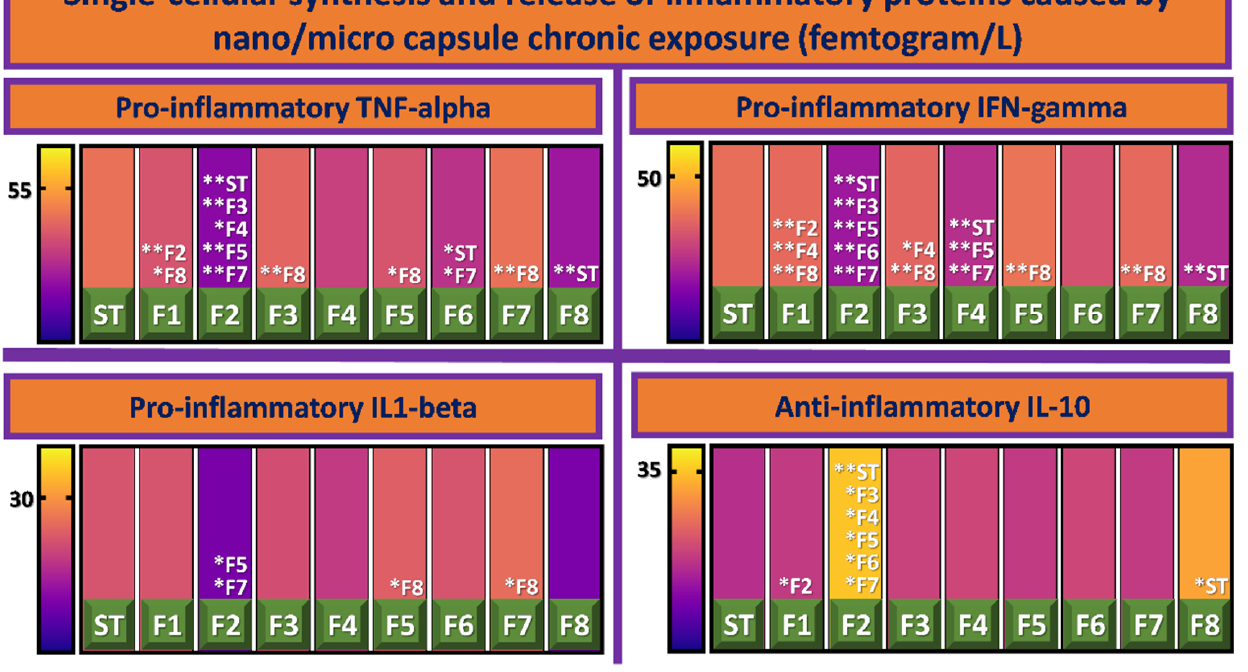
Figure 3. Single-cellular synthesis and release of inflammatory proteins caused by nano/micro capsule chronic exposure (femtogram/L). Inflammatory proteins include TNF-alpha ( top , left ), IFN- gamma ( top , right ), IL1-beta ( bottom , left ), and IL-10 ( bottom , right ). Data are mean ± standard error of the mean, n = 3. Singular asterisk denotes where p < 0.05, whereas double asterisk denotes p < 0.01.